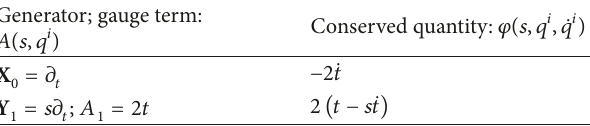
Table 37: Conserved quantities corresponding to each Noether symmetry.